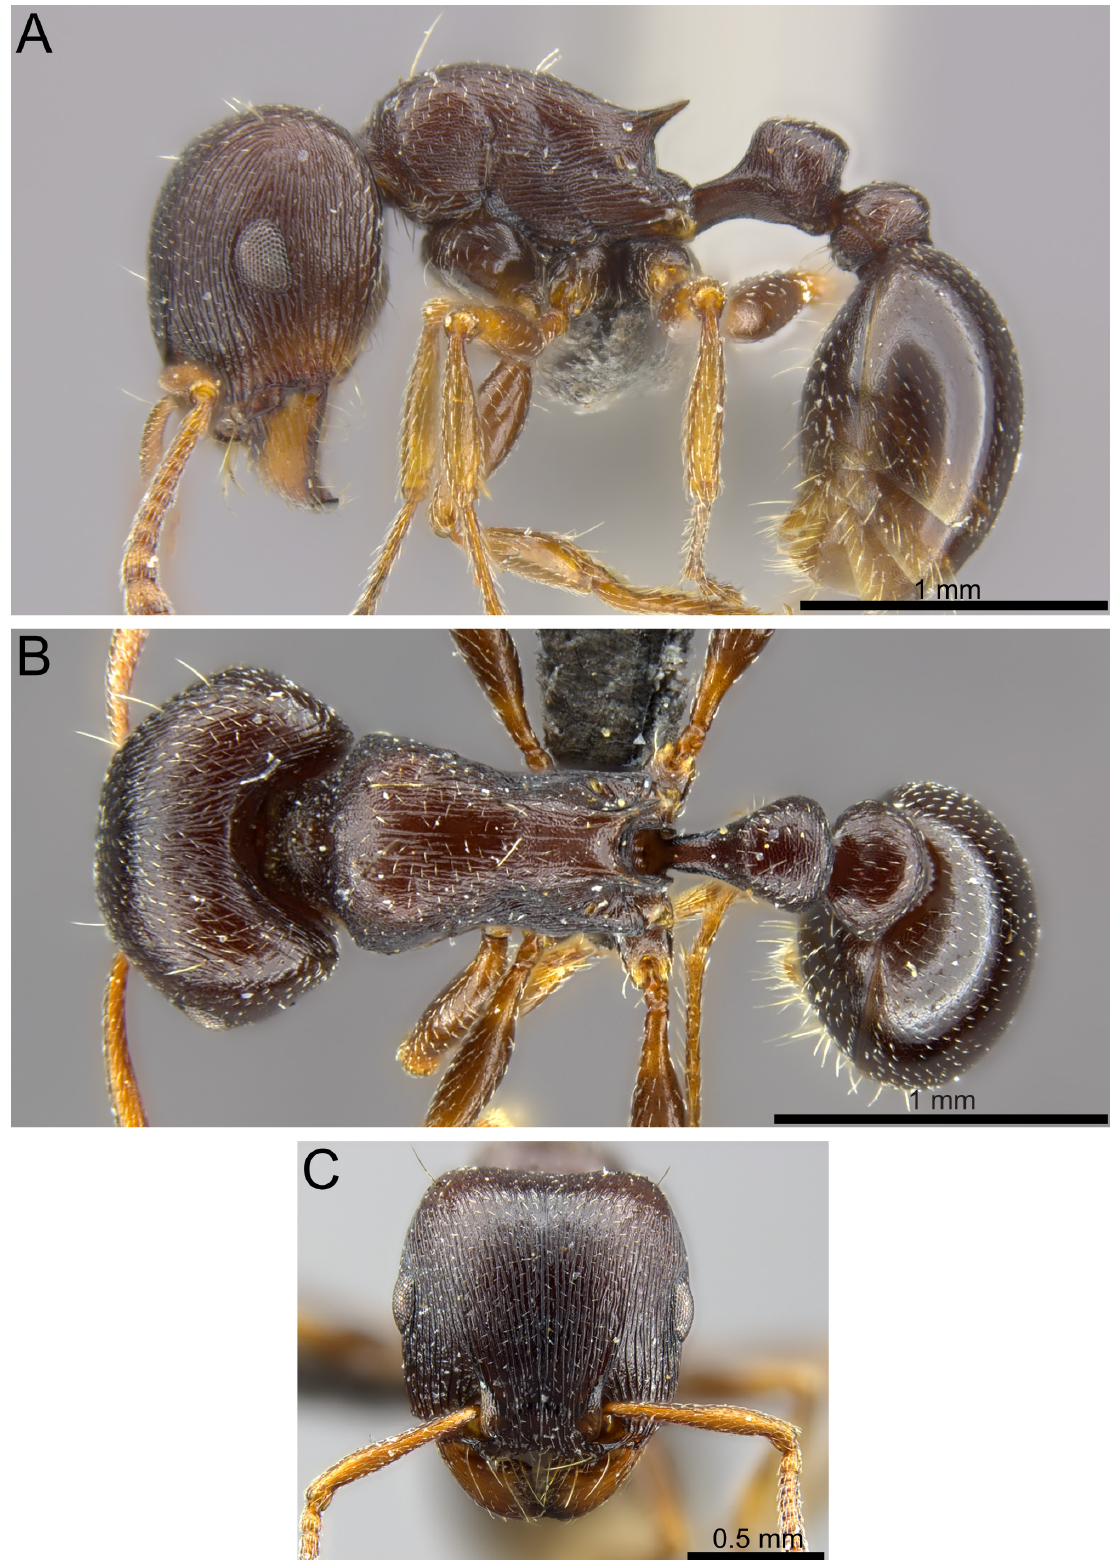
Fig. 23. Tetramorium solidum Emery, 1886 (CASENT0250960). A . Body in profile. B . Body in dorsal view. C . Head in full-face